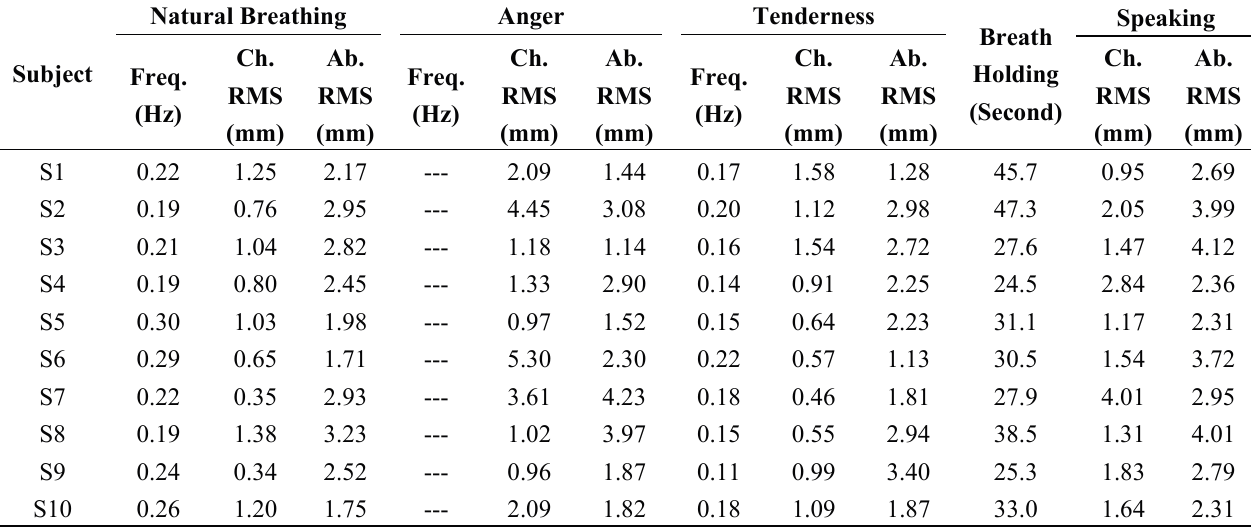
Table 3. Summary of Radar measured different respiratory patterns from the ten